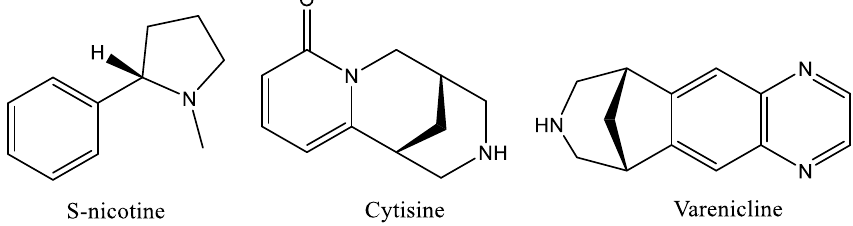
Figure 1. Chemical structure of alkaloids S-nicotine, Cytisine and smoking cessation drug Varenicline.